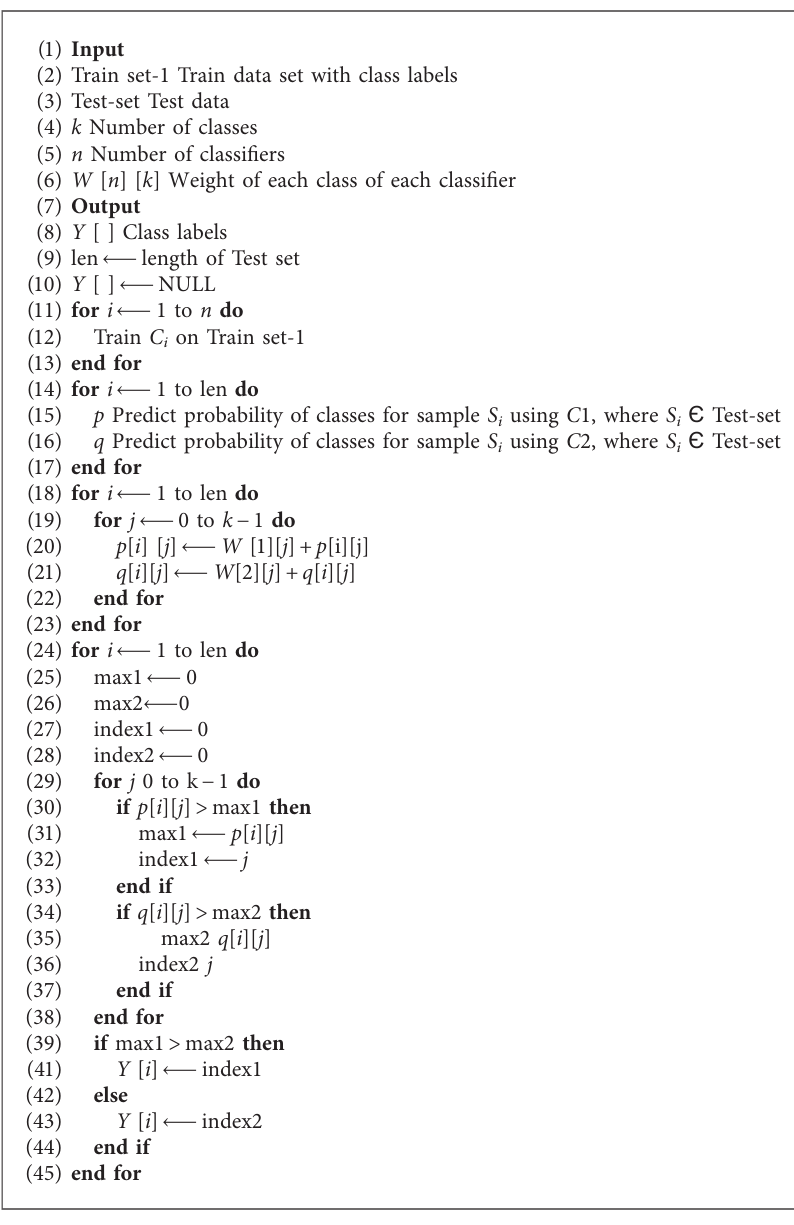
A LGORITHM 2: Algorithm for the selection of final Class for